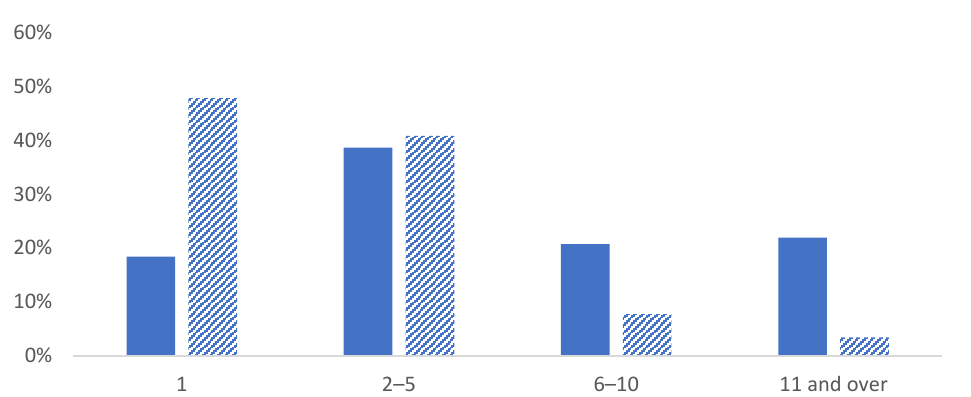
Figure 1. The number of PIM or DDI prescriptions per older adult. PIM, potentially inappropriate medication; DDI, drug–drug interaction. Table 2. Top 15 prescribed drugs in potentially inappropriate